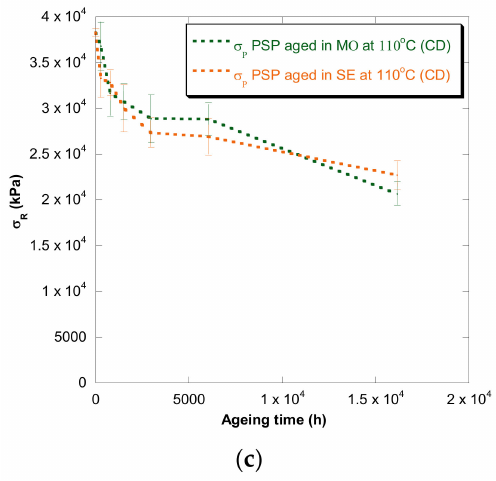
Figure 3. Evolution of the σ R in CD as a function of temperature for cellulose-board PSP 3055 aged in mineral oil and in synthetic ester at 150 ◦ C ( a ), 130 ◦ C ( b ), and 110 ◦ C ( c ).